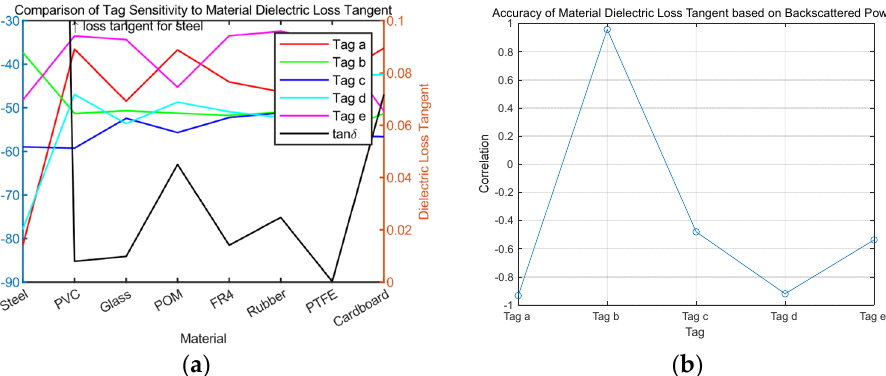
Figure 9. Backscattered power feature for dielectric loss tangent measurement ( a ) results and ( b ) accuracy in correlation.